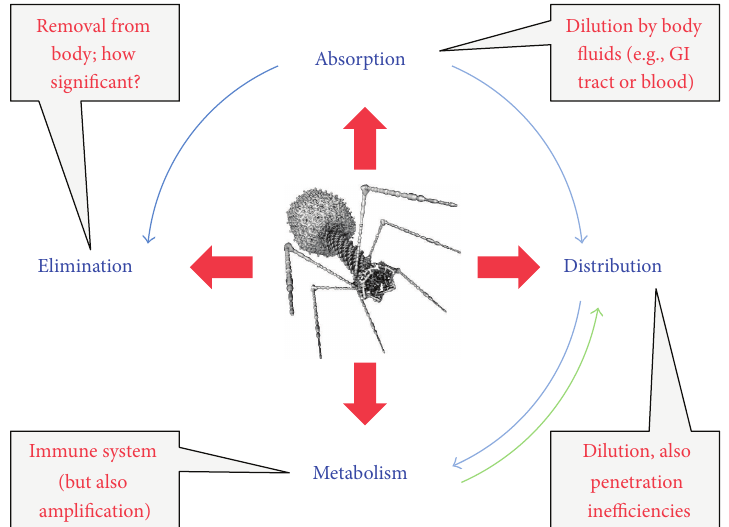
Figure 8: Impacts of pharmacokinetic phenomena during phage therapy. These processes occur in approximate temporal order as indicated by blue or inner arrows. Metabolism, via amplification of virion numbers, is also shown as contributing to increases in phage numbers that then may be distributed to other locations or compartments within the body (green or outer arrow). Amplification can also give rise to increased phage titers in blood, though this is not indicated. Also not indicated is activation of phage bactericidal activity, which can be viewed as an aspect of metabolism and one that precedes amplification (though which leads to amplification only given successful lytic, productive infection). Note that absorption and distribution too have the effect of increasing phage concentrations in specific compartments, the blood and nonblood tissues, respectively, as these are a means by which access to these compartments is achieved. These increases in concentration, however, are not relative to the initial phage dose but instead are relative to concentrations within compartments as observed prior to